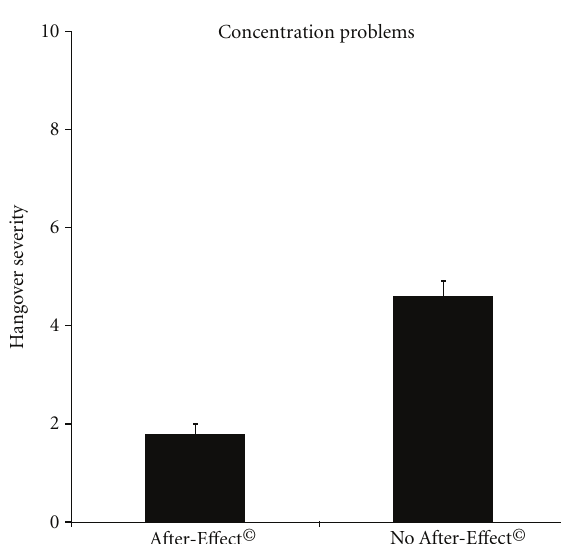
Figure 4: Overall hangover severity and total alcohol